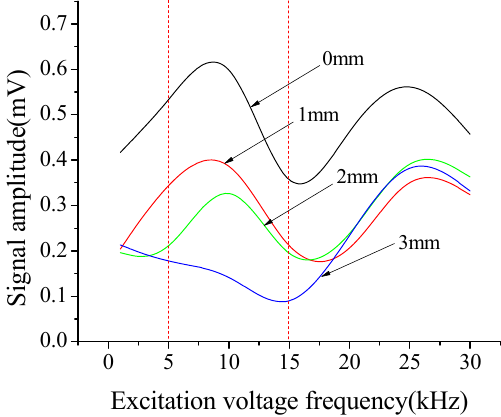
Figure 10. Relationship between the output signal amplitude and the excitation voltage frequency for the B-type specimen with different debonding thicknesses.